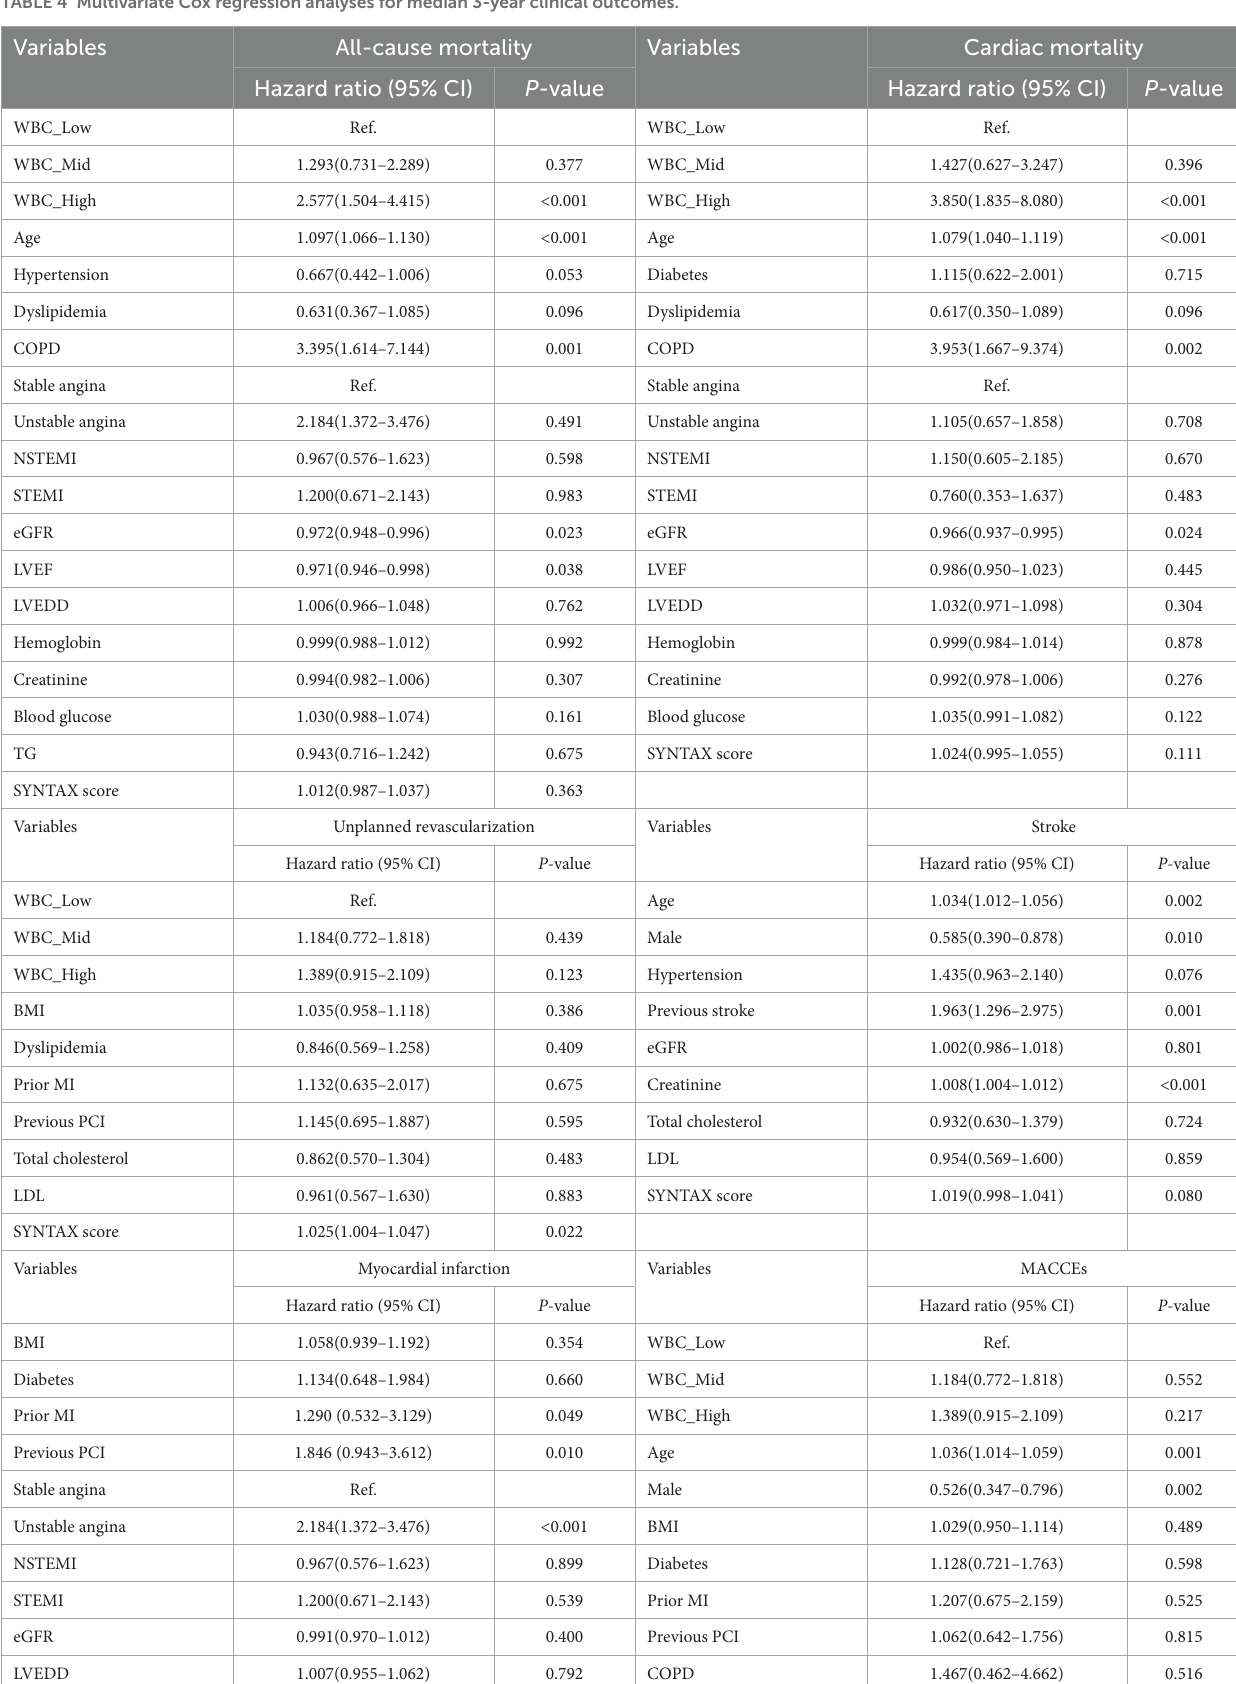
TABLE 4 Multivariate Cox regression analyses for median 3-year clinical